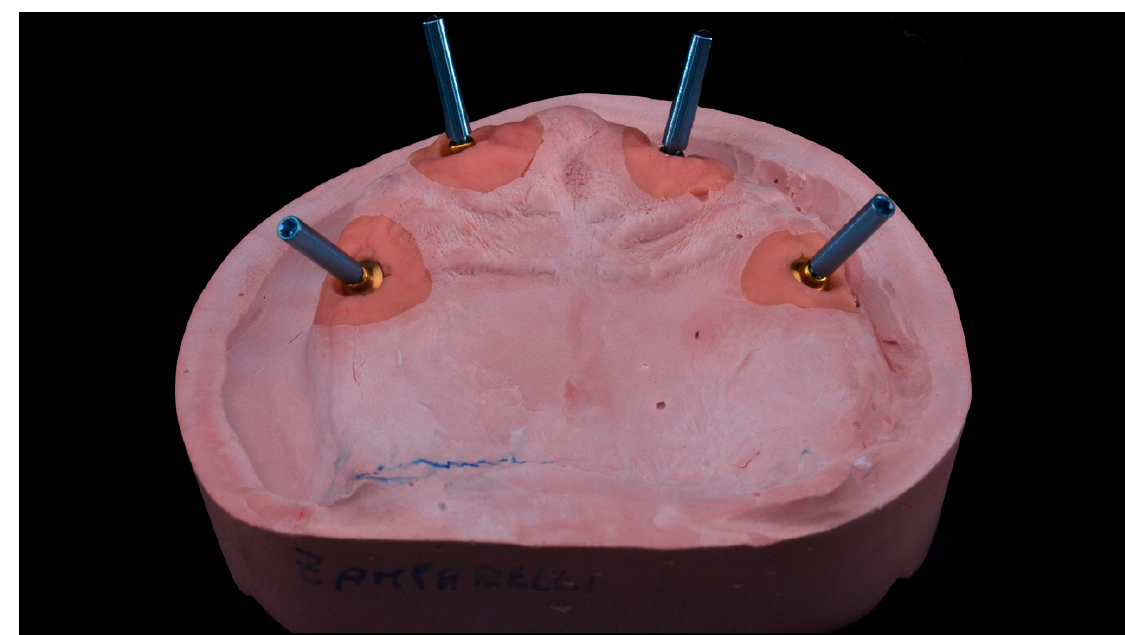
Figure 5. Master model showing the strong disparallelism among implants.